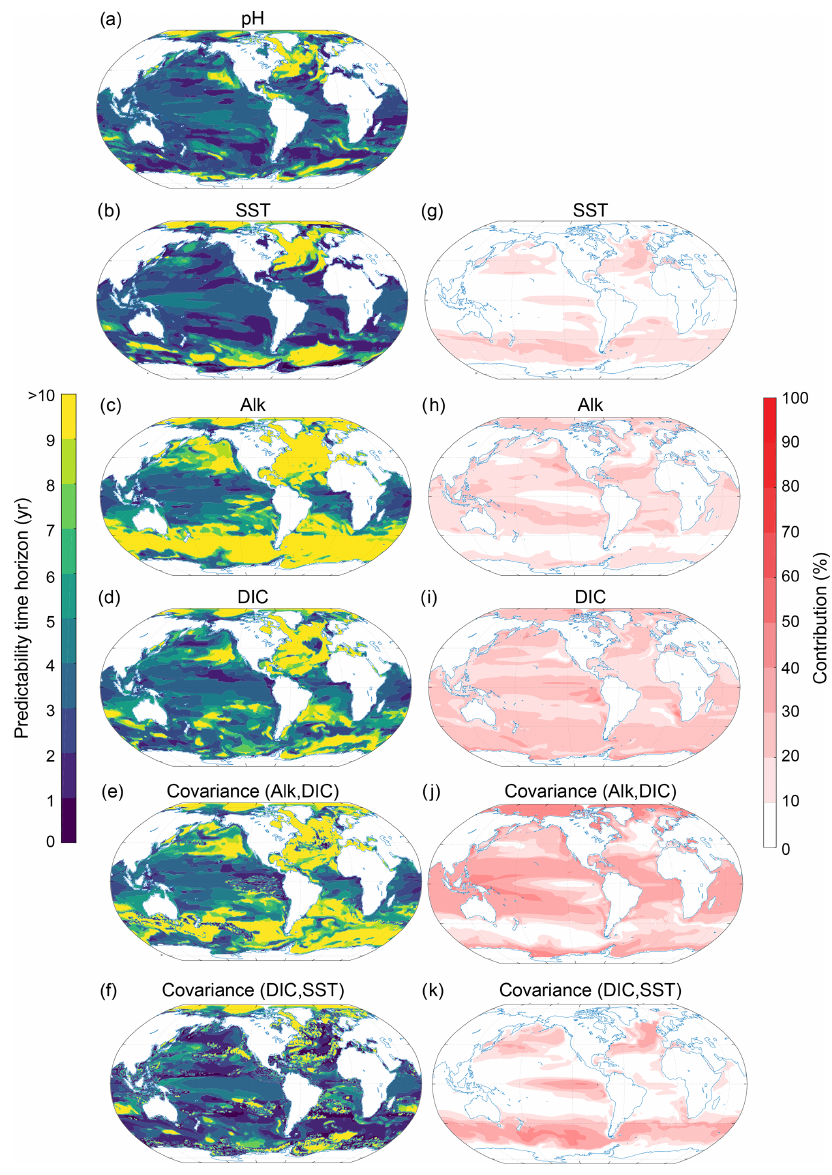
Figure 9. Spatial pattern of the (a–f) predictability horizons and (g–k) contribution of different terms to the predictability of pH at the surface. (a–f) Predictability time horizon for (a) pH, (b) SST, (c) Alk, (d) DIC, and the covariance between (e) Alk and DIC and (f) DIC and SST. (g–k) Percentage contributions of (g) SST, (h) Alk, (i) DIC, and covariance of (j) ALK and DIC and (k) DIC and SST relative to the sum of all terms. Red shading in panels (g) – (k) represents positive absolute values of the variance and covariance terms. The percentage contributions are shown as averages over the entire 10 years of the simulations. The percentage contributions do not change substantially over the 10 years (always within ± 5% of the 10-year averages). Note that the terms that do not contribute to pH predictability such as sea surface salinity and the covariances between sea surface salinity and all other terms as well as the covariance between SST and Alk are not shown